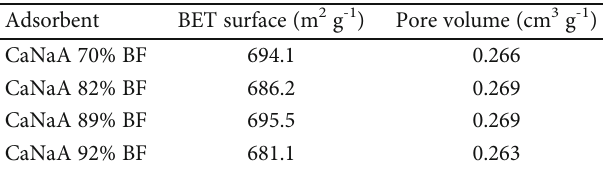
Table 2: BET speci fi c surface area and pore volume of the LTA zeolites.